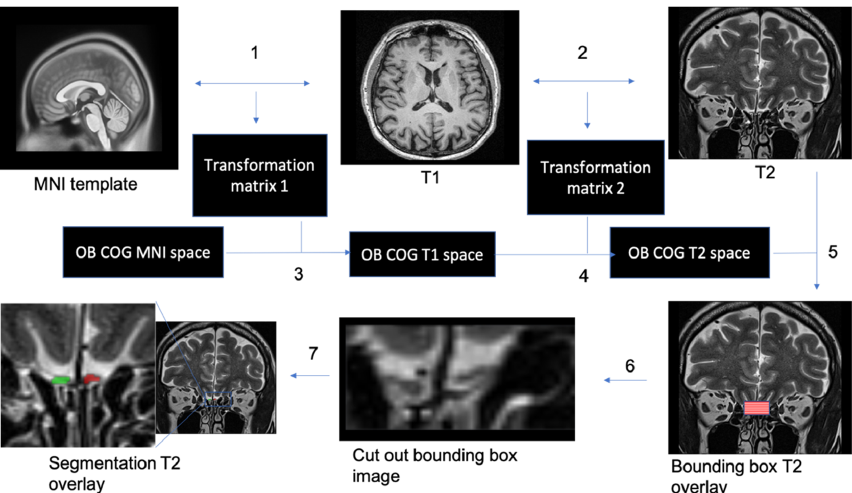
Figure 2. Automatic segmentation of the OBs. 1. T1 whole-brain image to MNI2009casym MNI template co-registration. 2. T2 high-resolution image to T1 whole-brain image co-registration. 3. Appling of inversed transformation matrix from step 1 to OB COG mask in MNI space. 4. Appling of